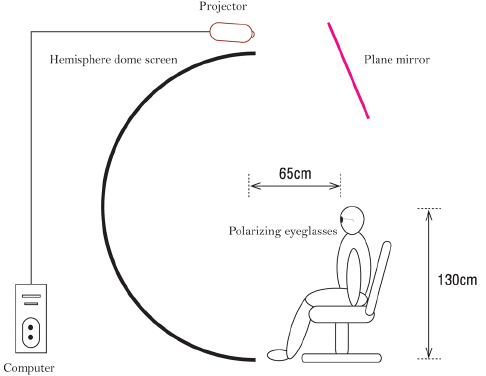
Figure 3. Schematic drawing of the 3D cyber dome test environment.